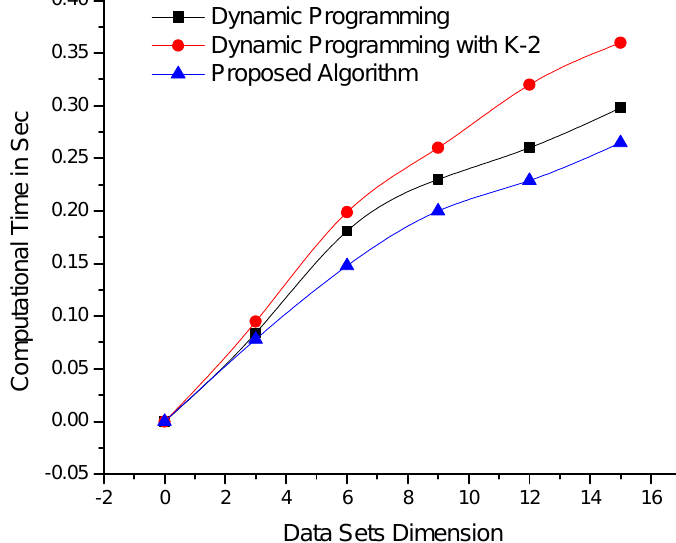
Figure 4. Comparison of the computational times of the proposed and dynamic programming-based algorithms—using data sets of variable length and constant dimensionality (the lowest lines i.e., minimum values are